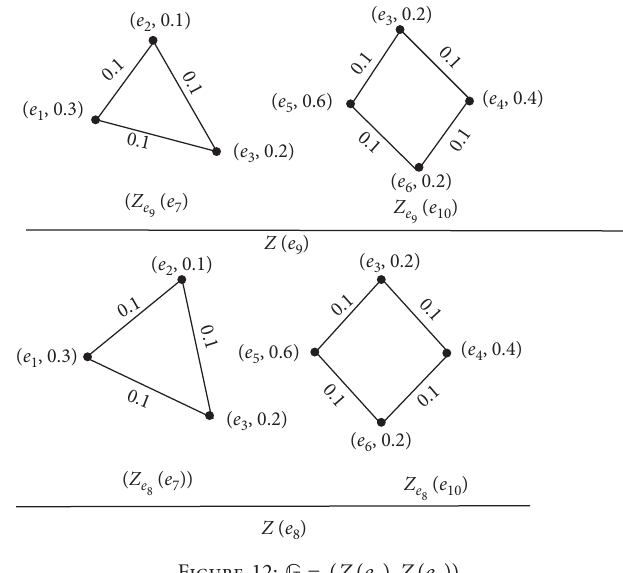
Figure 12: G � ( Z ( e